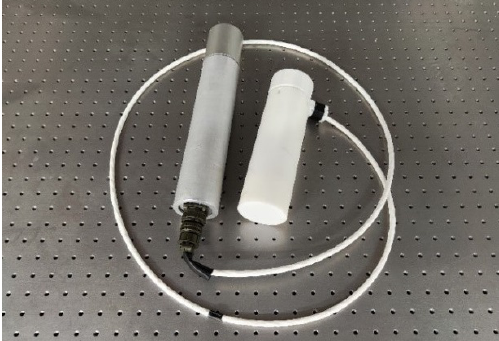
Figure 16. The integrated portable self-oscillating VCSEL-pumped cesium atomic magnetometer.